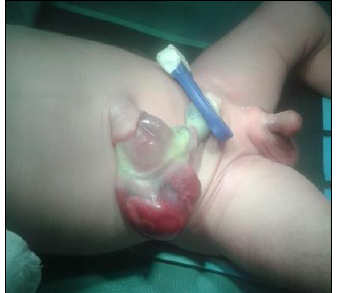
Figure 2: HUC having terminal ileum, cecum, and appendix as contents.